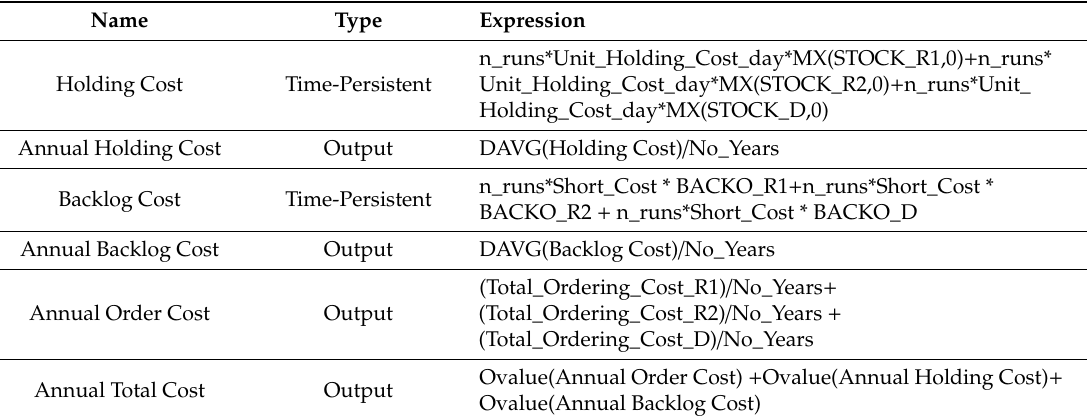
Table 2. Cost calculations using the “Statistic